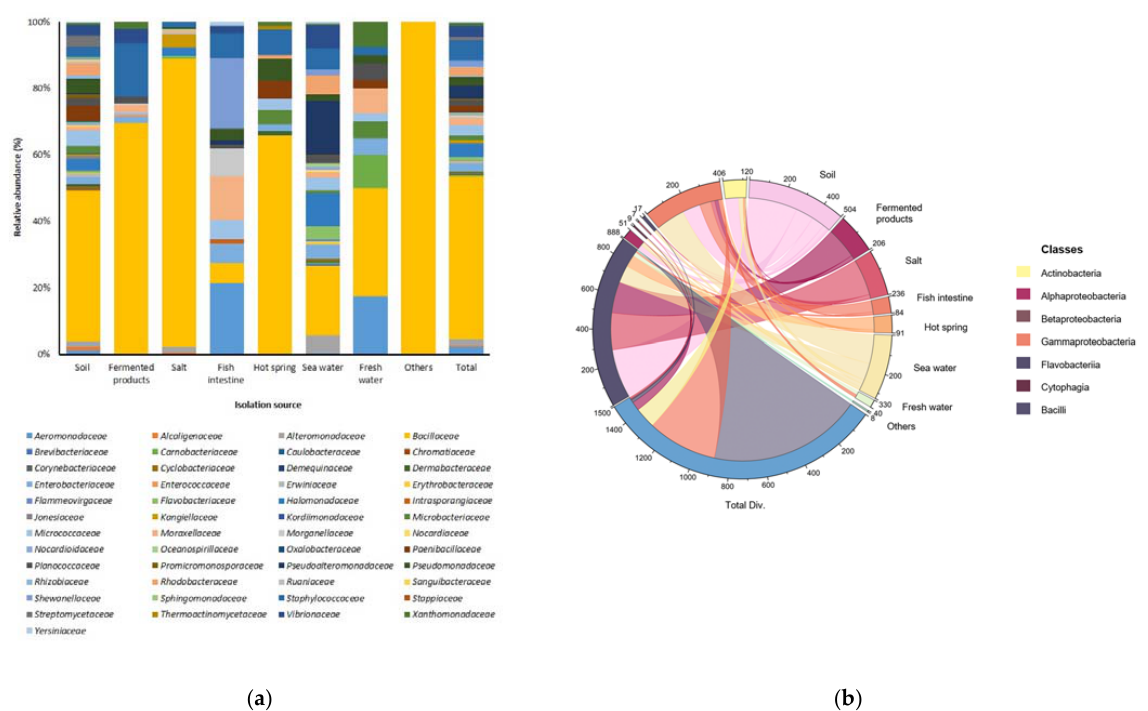
Figure 1. Relative abundances and bacterial diversity in specific environments. ( a ) Bacterial diversity at the family level; isolation sources were plotted on the horizontal axis, and the relative percentage of the family is visualized on the vertical axis, with each taxon shown as a specific color in the stacked columns. ( b ) A 3D chord diagram illustrating bacterial diversity at the class level; each arc shows overlapping diversity in specific environments. Total Div.: presenting the total diversity in specific environments (soil, fermented products, salt, fish intestine, hot spring, seawater, freshwater, and including other sources).